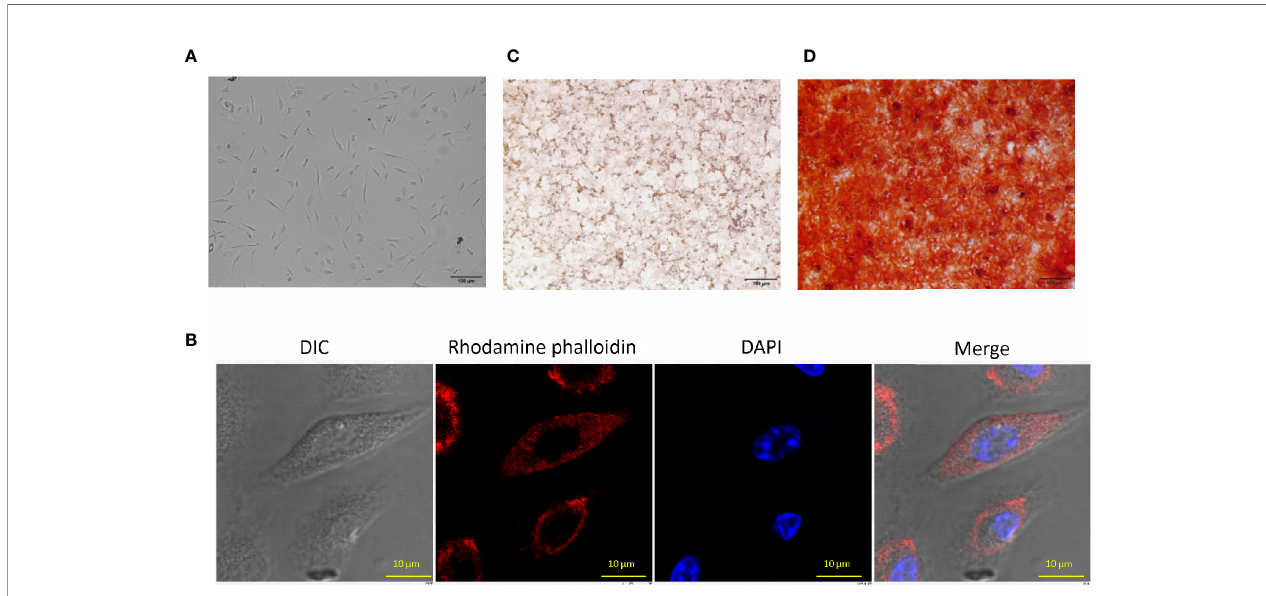
FIGURE 1 | Characteristics of mouse bone marrow-derived mesenchymal stem cells (MSC). (A) MSCs were isolated from mouse bone marrow and expanded to several passages that showed fi broblast-like morphology and arranged in the swirl. The photographs were taken using an Olympus IX71phase contrast microscope (10X). (B) MSCs were stained with rhodamine phalloidin (red) and DAPI (blue) and observed under a confocal microscope (60X). (C) Intercellular lipid vacuoles were stained with Oil Red O to determine the adipogenic differentiation potential of MSC. The pictures were taken using an Olympus phase contrast microscope (10X). (D) The MSC were stained with the Alizarin Red S to assess the osteogenic differentiation by the formation of calcium nodules. The pictures were clicked using a phase contrast microscope (10X). The photographs shown are the representative of three